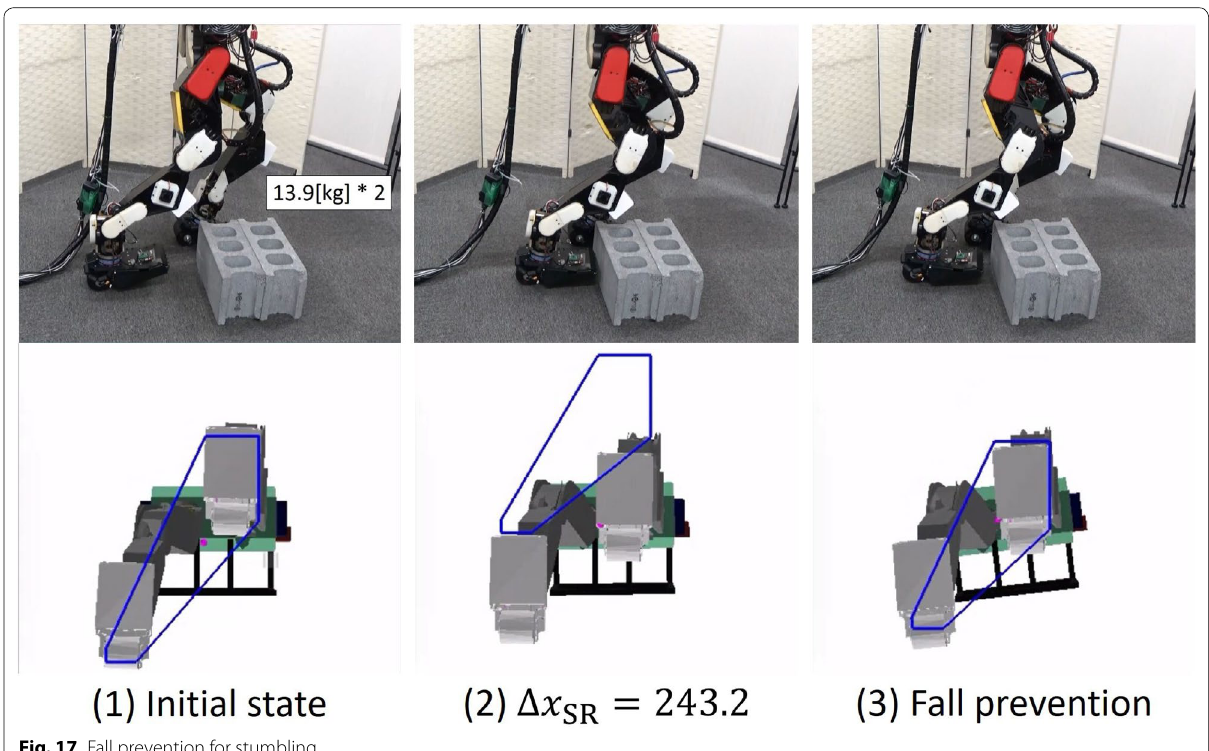
Fig. 17 Fall prevention for